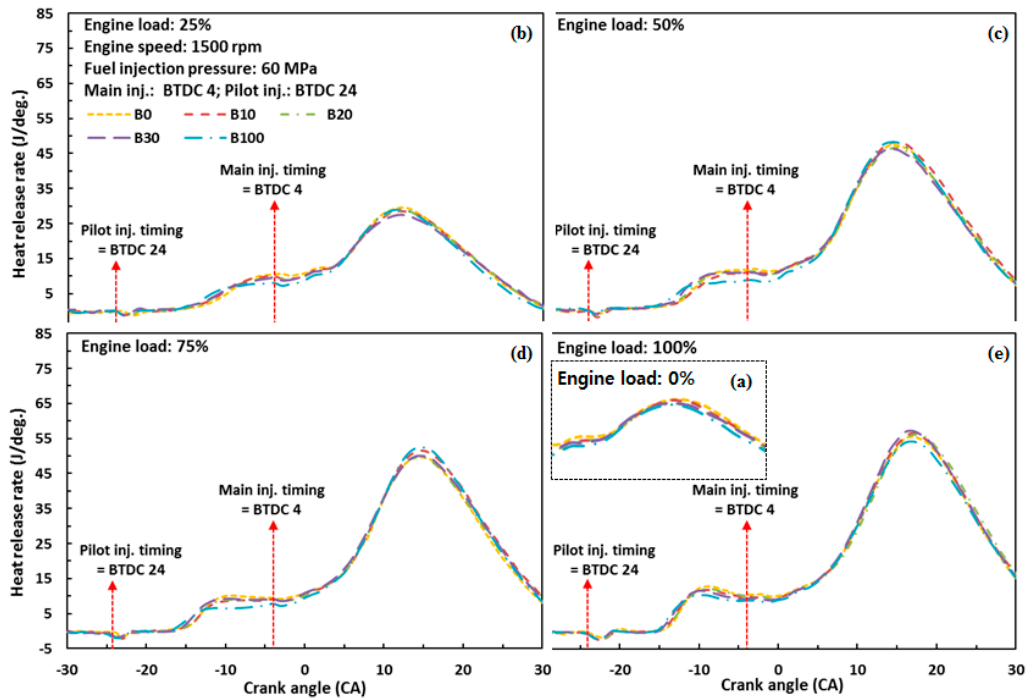
Figure 4. Effect of biodiesel blends on heat release rate at each load. ( a ) Engine load: 0%; ( b ) Engine load: 25%; ( c ) Engine load: 50%; ( d ) Engine load: 75%; ( e ) Engine load: 100%.